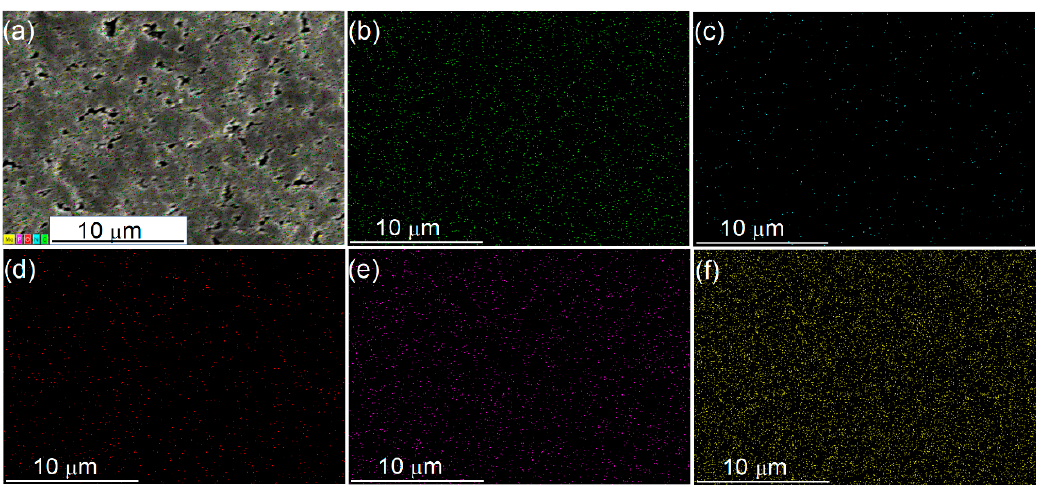
Figure 4. SEM / EDX-mapping of the 40 -PMo 12 / F 3 -PAN catalyst. ( a ) SEM photo, ( b ) C element, ( c ) N Figure 4. SEM/EDX-mapping of the 40 -PMo 12 /F 3 -PAN catalyst. ( a ) SEM photo, ( b ) C element, ( c ) N element, ( d ) O element, ( e ) P element, and ( f ) Mo element, ( d ) O element, ( e ) P element, and ( f ) Mo element.